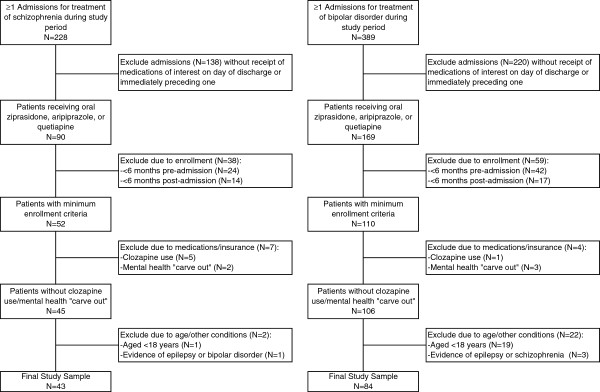
Sample selection criteria.